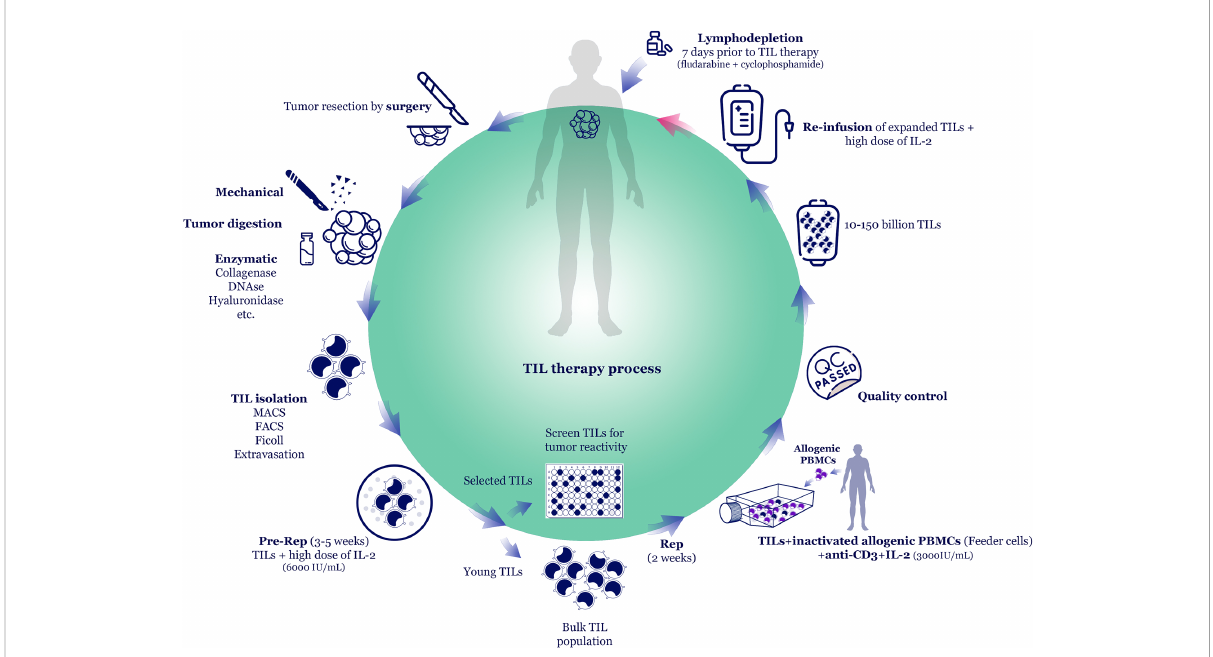
FIGURE 1 TIL therapy process. The most common TIL production method is TIL isolation from resected tumor tissue and expansion in vitro using rapid expansion protocol (REP). The tumor is excised by surgery and mechanically cut into small pieces. Then, tumor pieces can be further digested by adding enzymes, such as collagenases, DNAse, hyaluronidase, etc. TILs are isolated via Ficoll density gradient centrifugation or speci fi c cell sorting methods, such as magnetic- or fl uorescence-activated cell sorting (MACS/FACS). In the pre-REP phase, TILs undergo primary expansion in the presence of high-dose interleukin-2 (IL-2). In some methods, following pre-REP, the tumor-speci fi c TILs are selected and further expanded (selected TIL method). However, to reduce in vitro culture period and to maintain TILs ef fi cacy, some studies skip the TIL selection process and expand the bulk TILs (young TIL method). In REP, high dose IL-2, anti-CD3, and irradiated allogeneic peripheral blood mononuclear cells (PBMCs) as feeder cells are added to the TIL culture. The expanded cell products that passed the quality controls (sterility, negativity